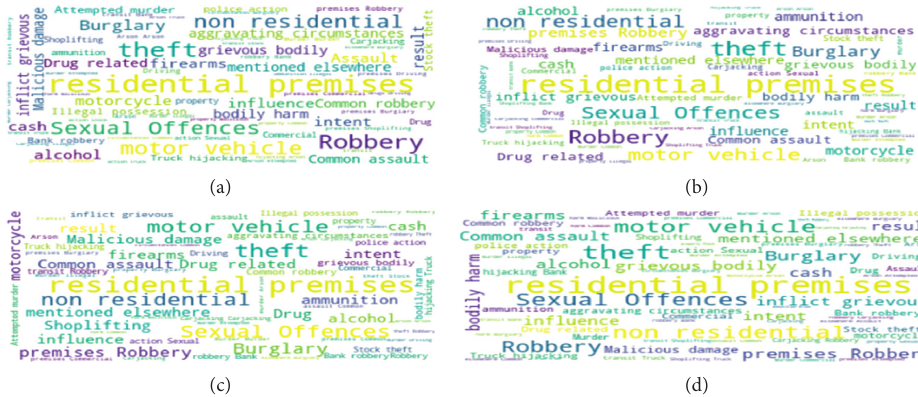
Figure 7: Word cloud of the crime category in (a) Gauteng, (b) KwaZulu-Natal, (c) Western Cape, and (d) Eastern